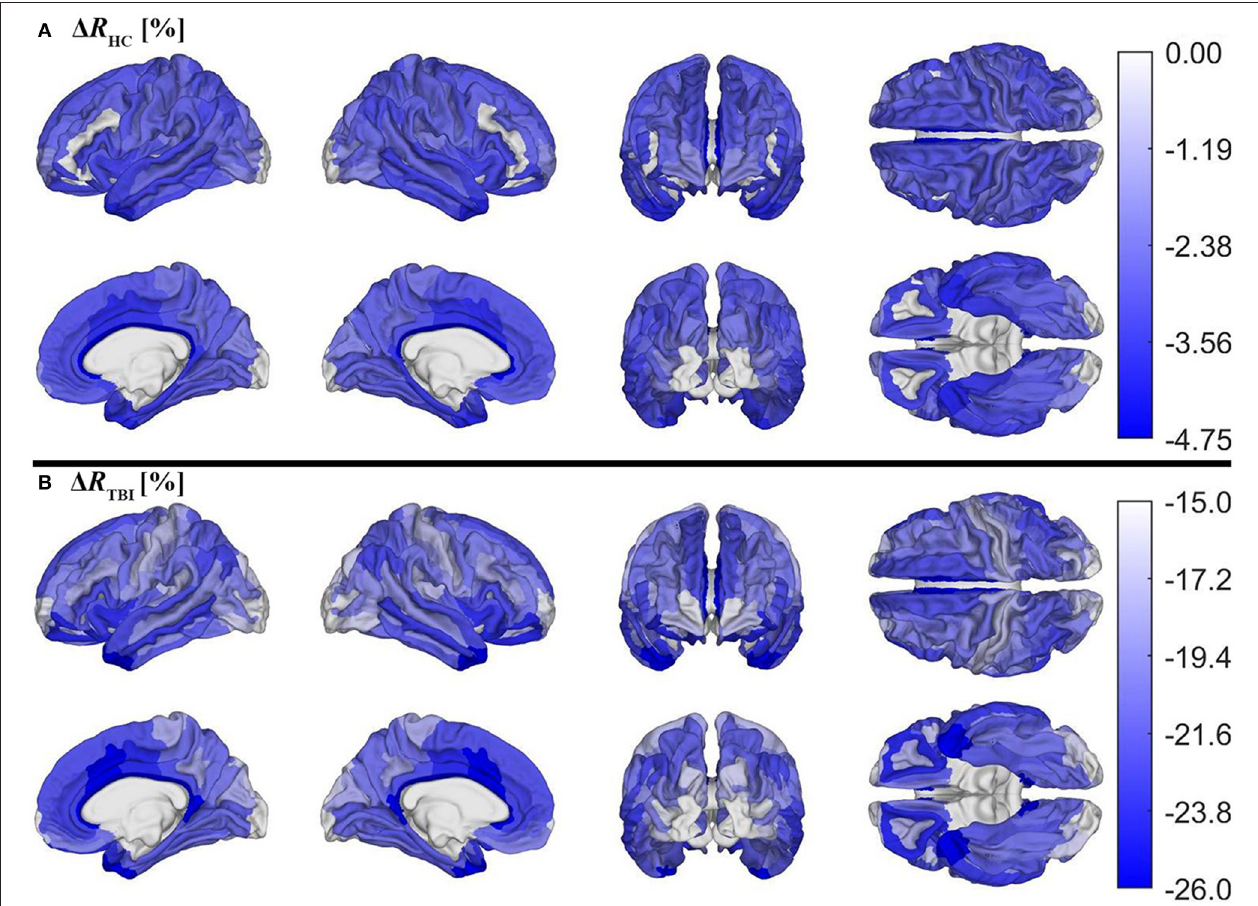
FIGURE 5 | Cortical maps of the percentage change 1 R across timepoints for (A) HCs and (B) mTBI participants, corrected for multiple comparisons. 1 R was calculated as 1 R = ( R f − R b ) / R b , where R b indicates R values at baseline and R f indicates R values at follow-up. 1 R values were averaged over subjects and then within each region. Note that different color axes are used for each group to emphasize between-group differences across the cortex. Darker blue indicates more demyelination. Both groups lose the largest proportion of myelin in temporal, cingulate, and insular